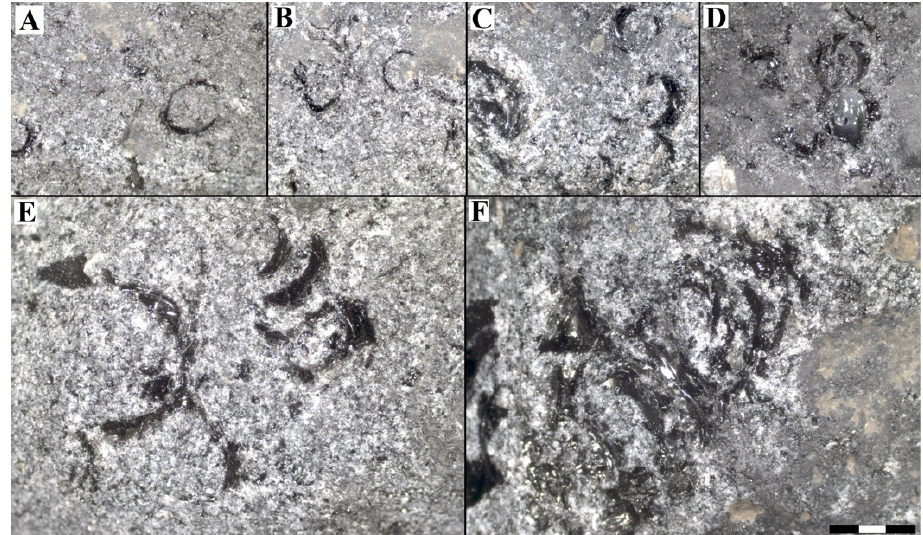
Figure 8. Different types of percussion marks generated in the experiment for the broken samples: ( A – E ) crescent, ( C , D ) pseudo-circular, ( D ) circular, ( B – F ) irregular. The bottom right bar measures a total of 3 mm, the same from ( A – F ).